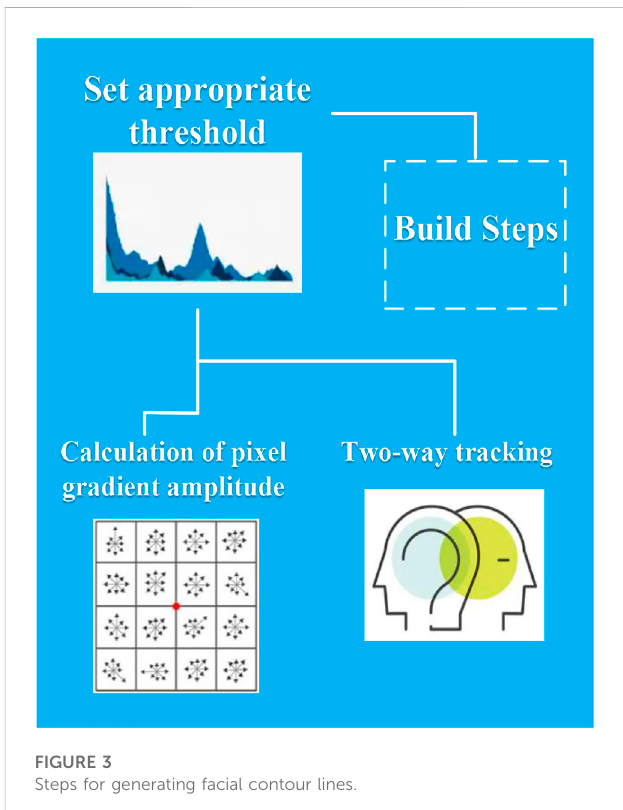
FIGURE 3 Steps for generating facial contour